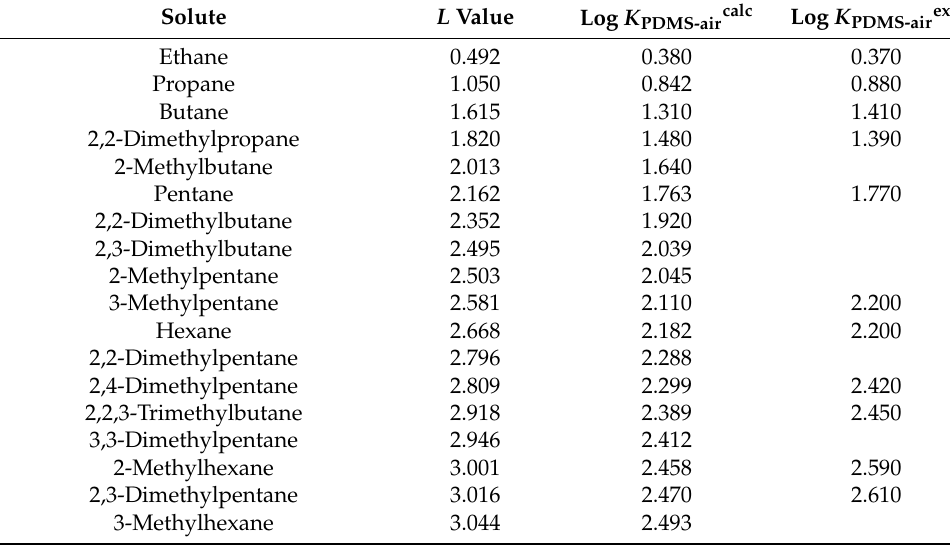
Table 2. Comparison of the Abraham Model Calculated versus Experimental Logarithms of the Air-to-Polydimethylsiloxane Partition Coefficients, log K PDMS-air , for the Linear Alkanes, and Methyl- and Ethyl-branched Alkanes Considered in the Current